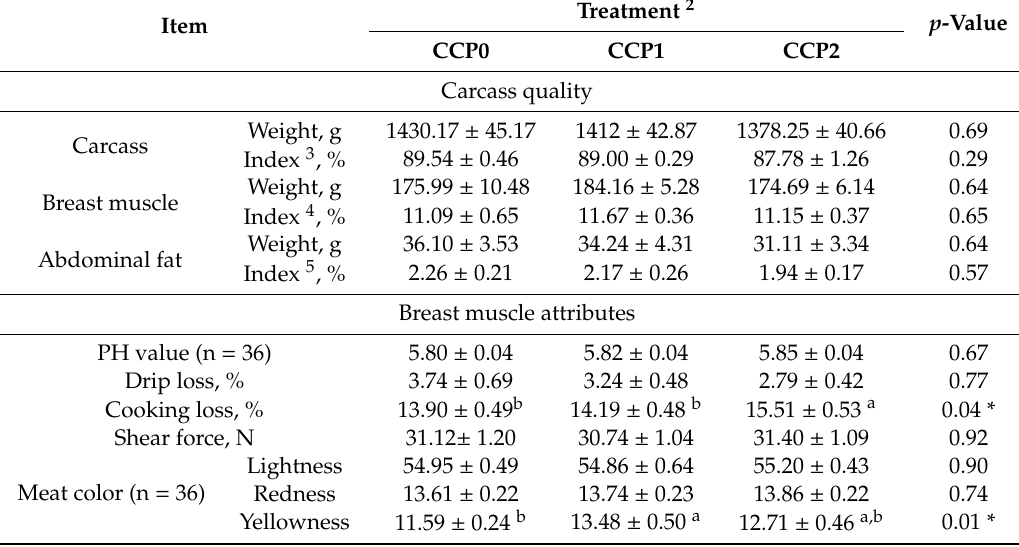
Table 5. E ff ect of dietary Camellia oleifera cake polysaccharides supplementation on meat quality of yellow broilers ( ± SEM 1 ) at 50